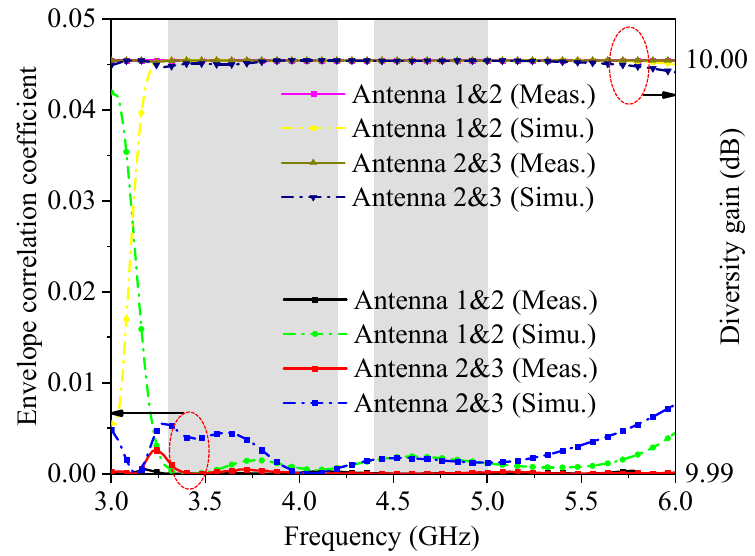
Figure 15. Computed ECC and DG of the designed antenna.